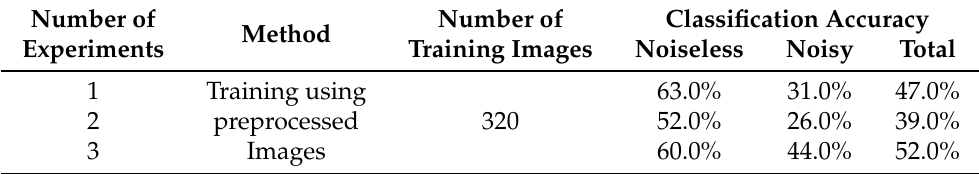
Table 3. Classification accuracy of the network trained using preprocessed images.